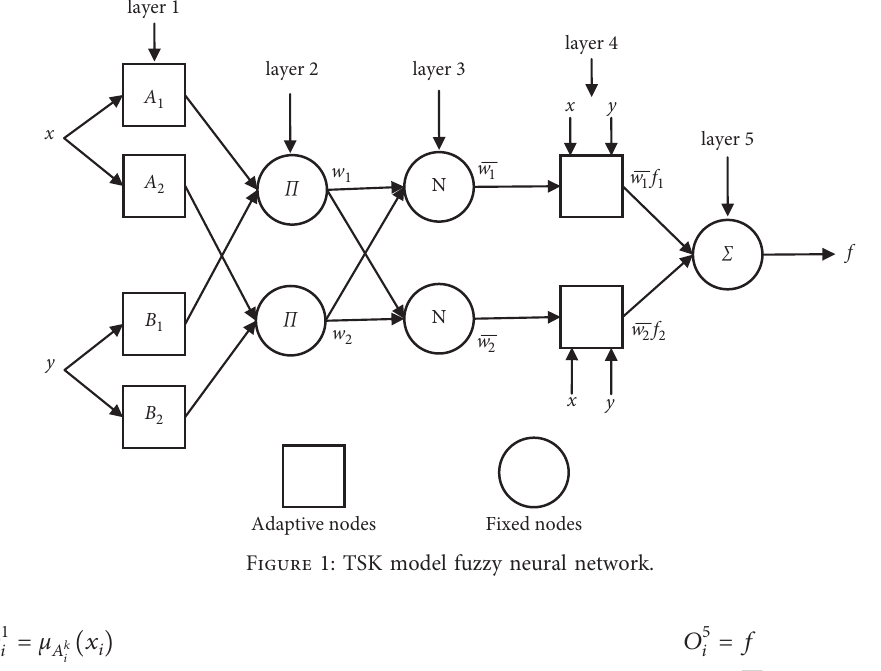
Figure 1: TSK model fuzzy neural